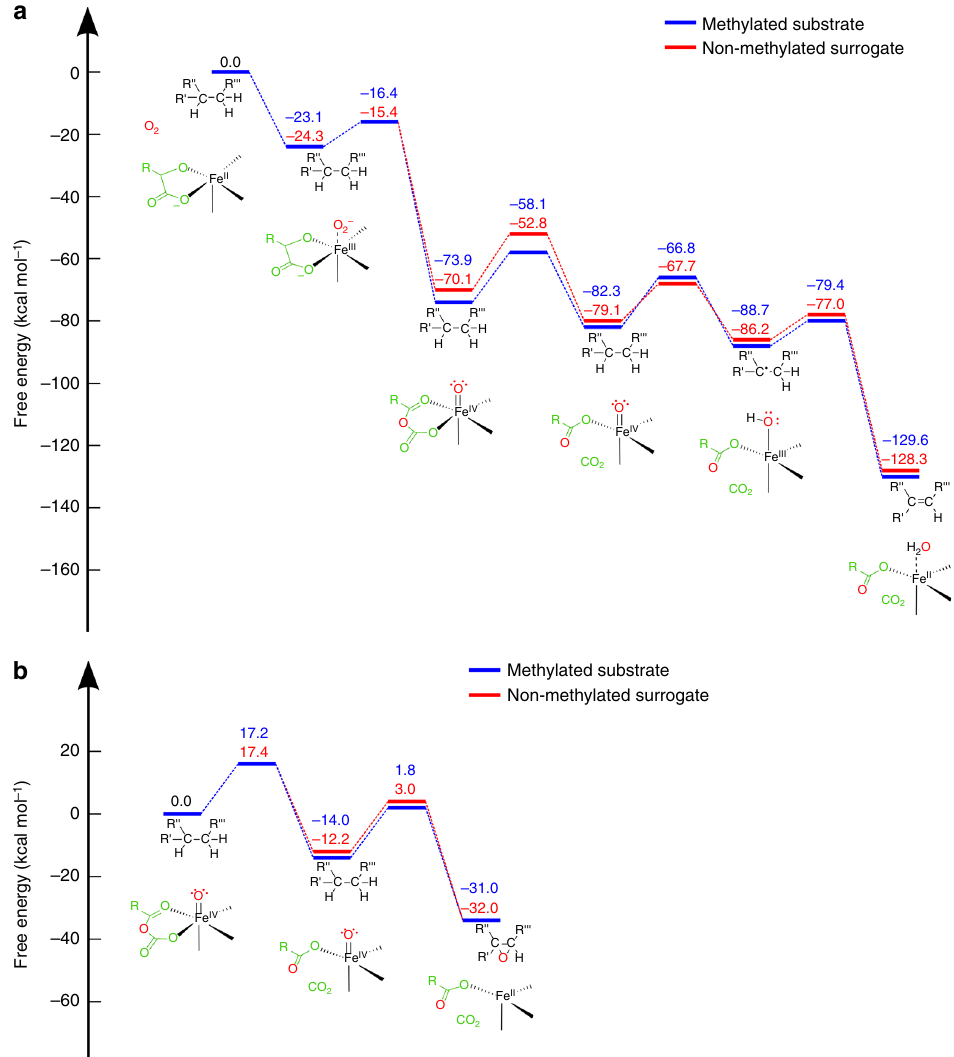
Fig. 2 Calculated catalytic cycle and energetics of AsqJ. a The fi rst part of the reaction cycle, comprising oxygen activation, decarboxylation of α KG, and two subsequent PCET reaction steps. b The second part of the reaction involving epoxidation of the substrate. All energies refer to free energies calculated in the quintet state at B3LYP-D3/def2-TZVP/ ε = 4 level of theory with vibrational and entropic corrections at the B3LYP-D3/def2-SV(P)/ ε = 4 level. Barriers are obtained from reaction pathway optimizations (Methods). See also Supplementary Movies 1 and 2, and Supplementary Figs. 3 and 9 for the optimized intermediate structures. Free energy pro fi les along the triplet surface are shown in Supplementary Figs. 6 and